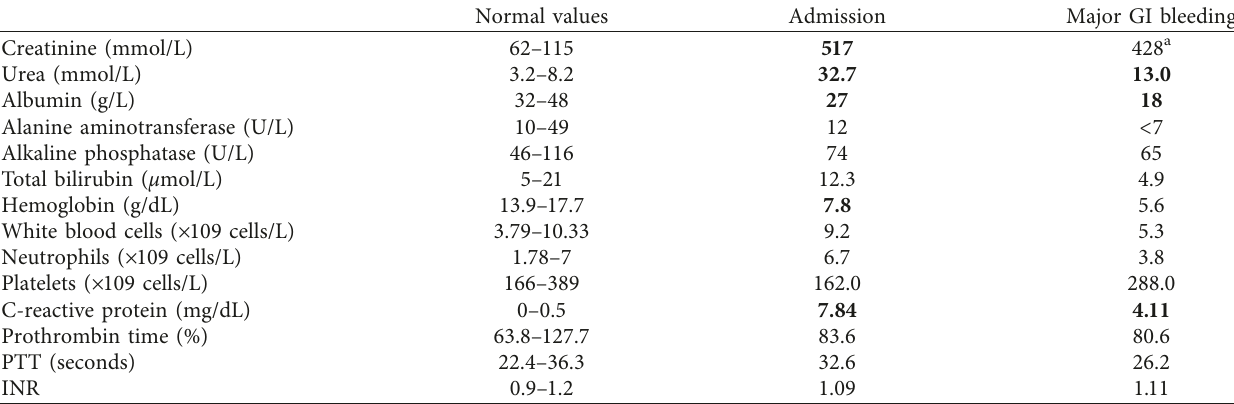
Table 1: Laboratory results during admission and massive GI bleeding.